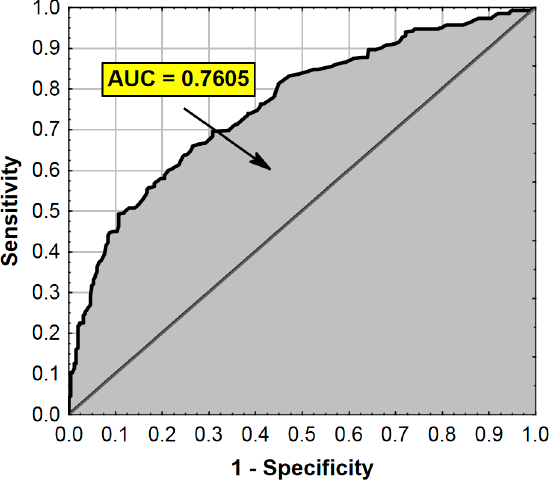
Figure 1. ROC curve and AUC value for the regression model from Table 4. AUC—Area Under the Curve (measure of diagnostic accuracy).